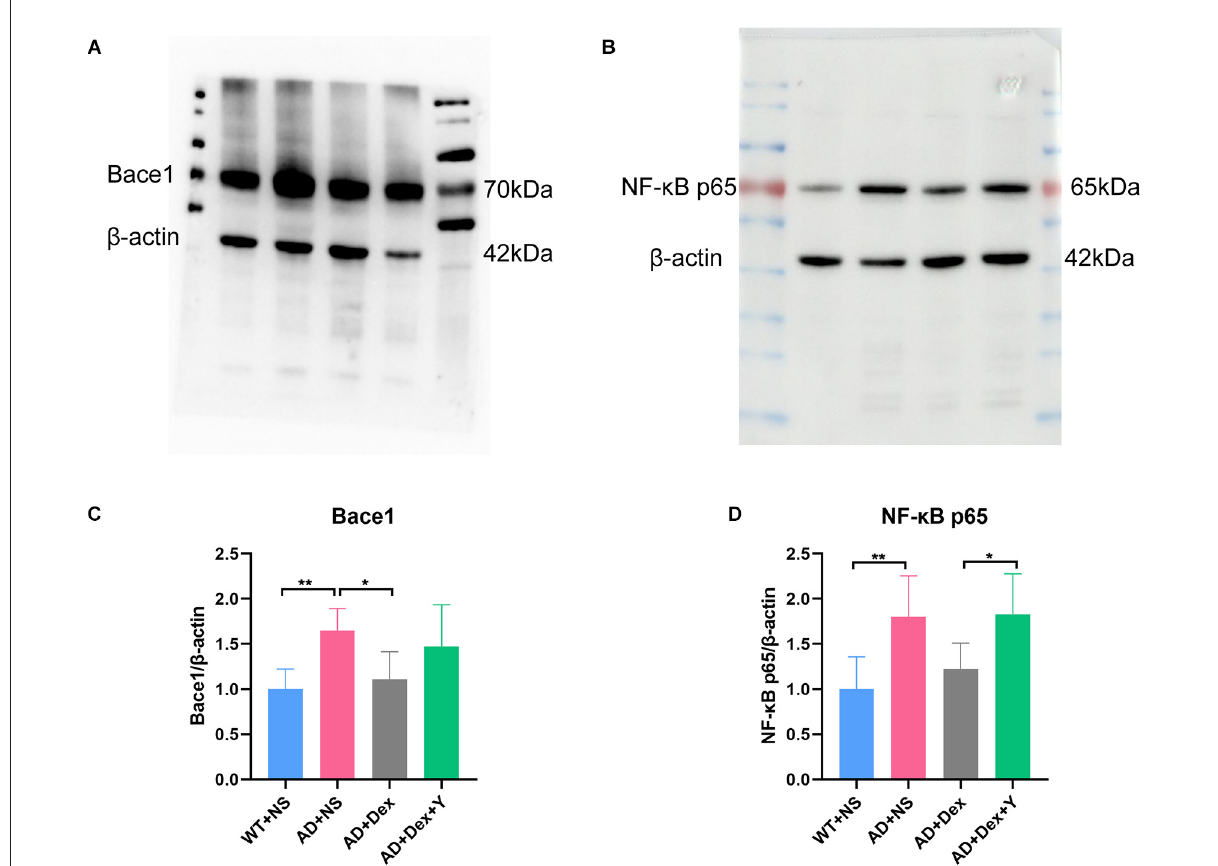
FIGURE6 Dexmedetomidine downregulates the expression of Bace1 (A,C) and NF- κ B p65 ( B,D ; means ± SD, ANOVA, * p < 0.05, ** p < 0.01). (A) Western blotting data showing Bace1 expression levels in the hippocampus. (B) Western blotting data of NF- κ B p65 expression levels in the hippocampus. (C) The bar graph represents Bace1 expression levels in the hippocampus. (D) The bar graph represents NF- κ B p65 expression levels in the hippocampus ( n = 6 in each